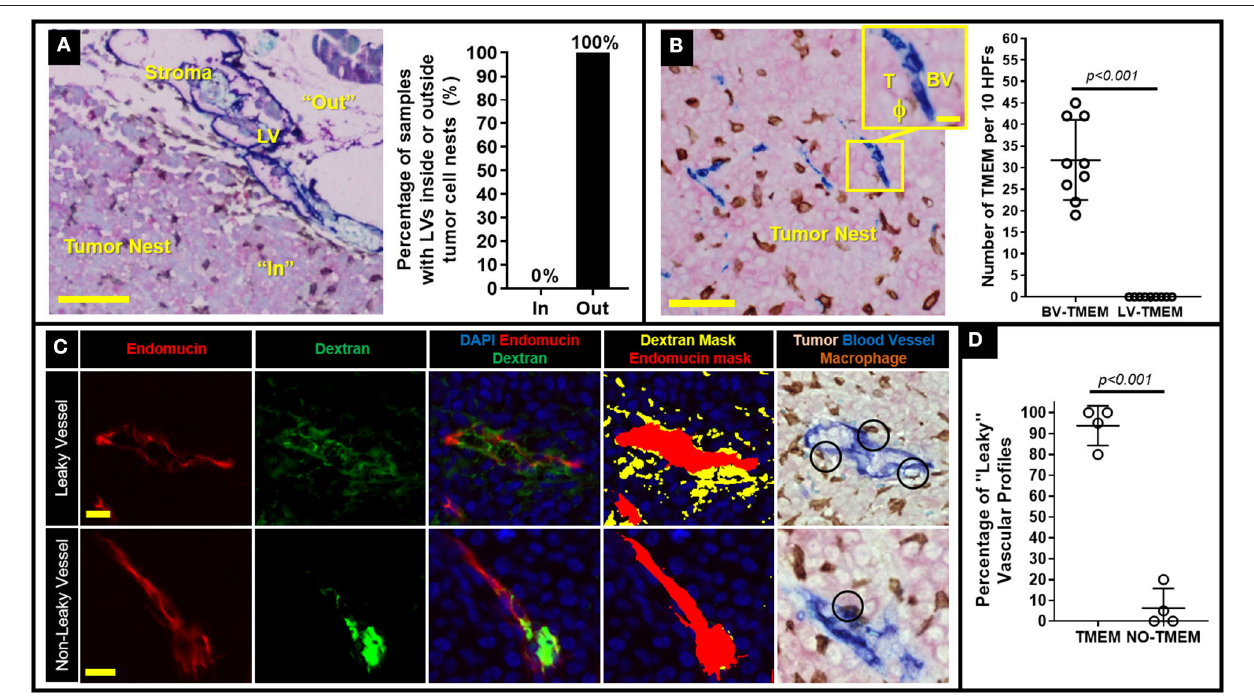
FIGURE 1 | Decreasing TMEM doorway function suppresses TMEM-mediated vascular permeability and cancer cell intravasation from established lymph node metastasis. (A) Left: Lymph node metastasis taken from a mouse with an MDA-MB-231 primary breast tumor and stained for lymphatic vessel TMEM (LV-TMEM). Pink = Tumor cells (stained for panMena), Brown = macrophages (stained for CD68), Blue = lymphatic vessels (stained for D2-40). Lymphatic vessels (LV) are only seen in the tumor stroma (“Out”) and not in the tumor nest (“In”) and no lymphatic vessel TMEM (LV-TMEM) were identified in the tumor nests. Bar = 100 µ m. Right: Frequency (%) of lymphatic vessels inside or outside the tumor nests in established lymph node metastases in mice. (B) Left: Lymph node metastasis taken from a mouse with an MDA-MD-231 primary breast tumor and stained for blood vessel TMEM (BV-TMEM). Pink = Tumor cells (stained for panMena), Brown